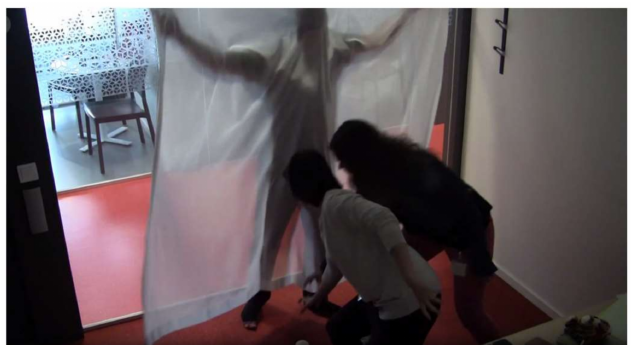
Figure 5. Screenshot of participants of the Move:ie workshop while enacting one of the ideas during the second session, to package it in a video-prototype